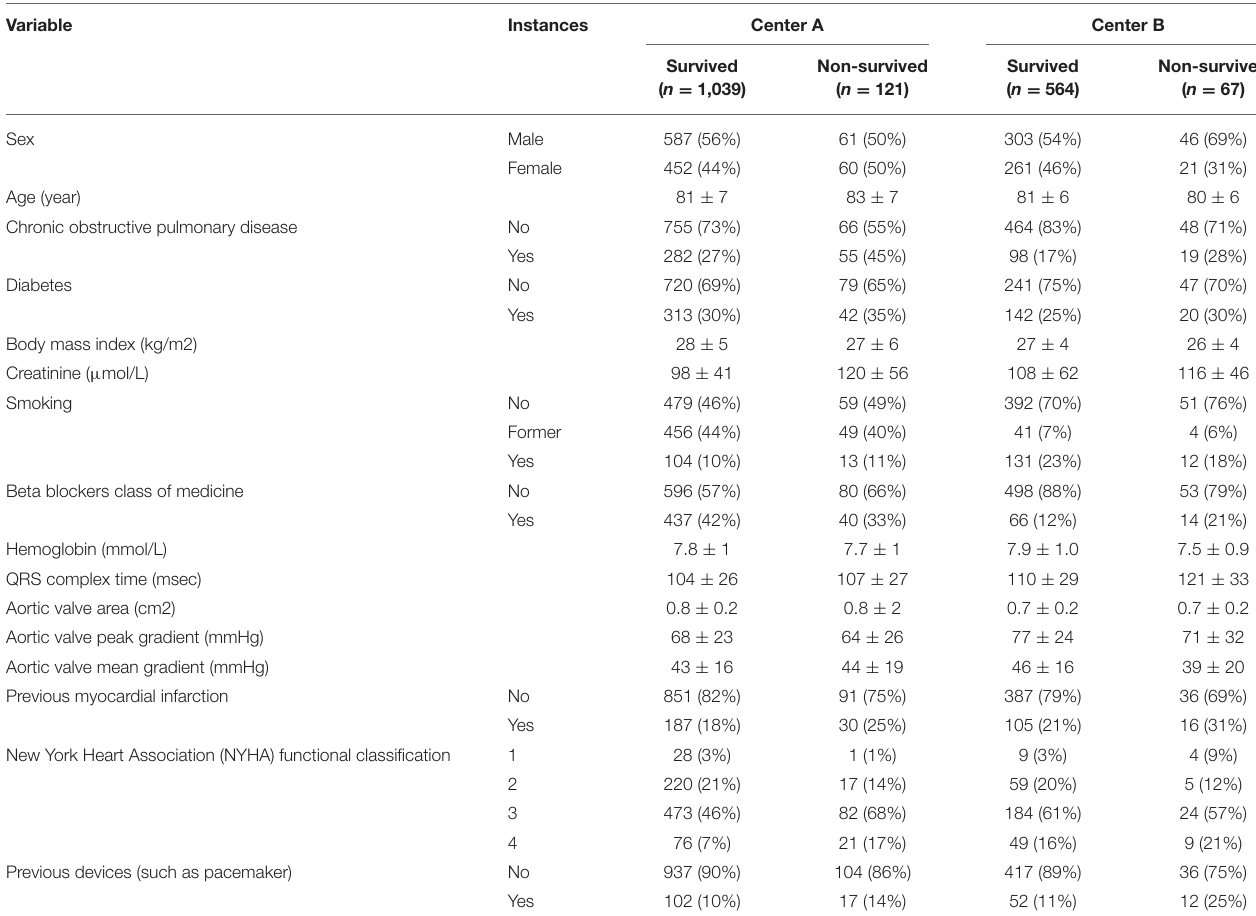
TABLE 1 | Descriptive statistics of the study group, mean ± SD or N (%).